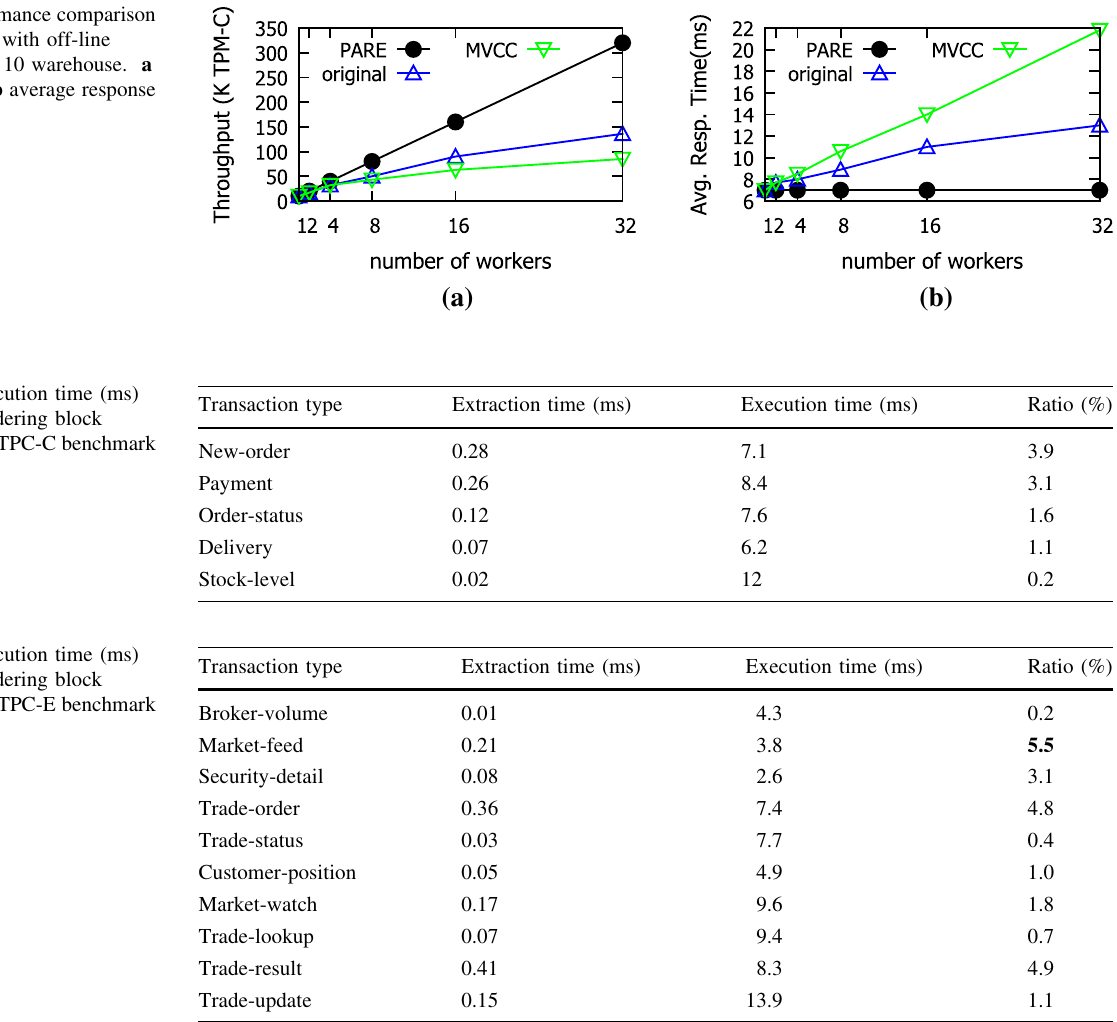
Fig. 8 Performance comparison under TPC-C with off-line reordering on 10 warehouse. a Throughput, b average response time